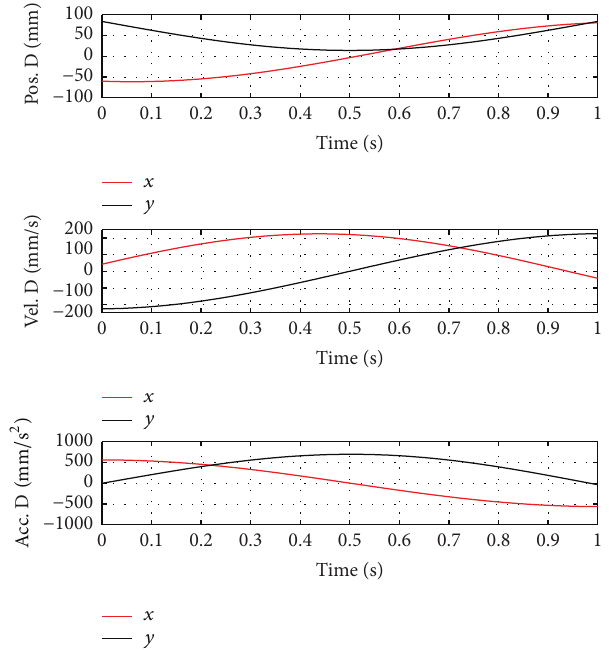
Figure 8: Result of position, velocity, and acceleration of point D, for 180 ∘ ≤ 𝜑 ≤ 360 ∘ .